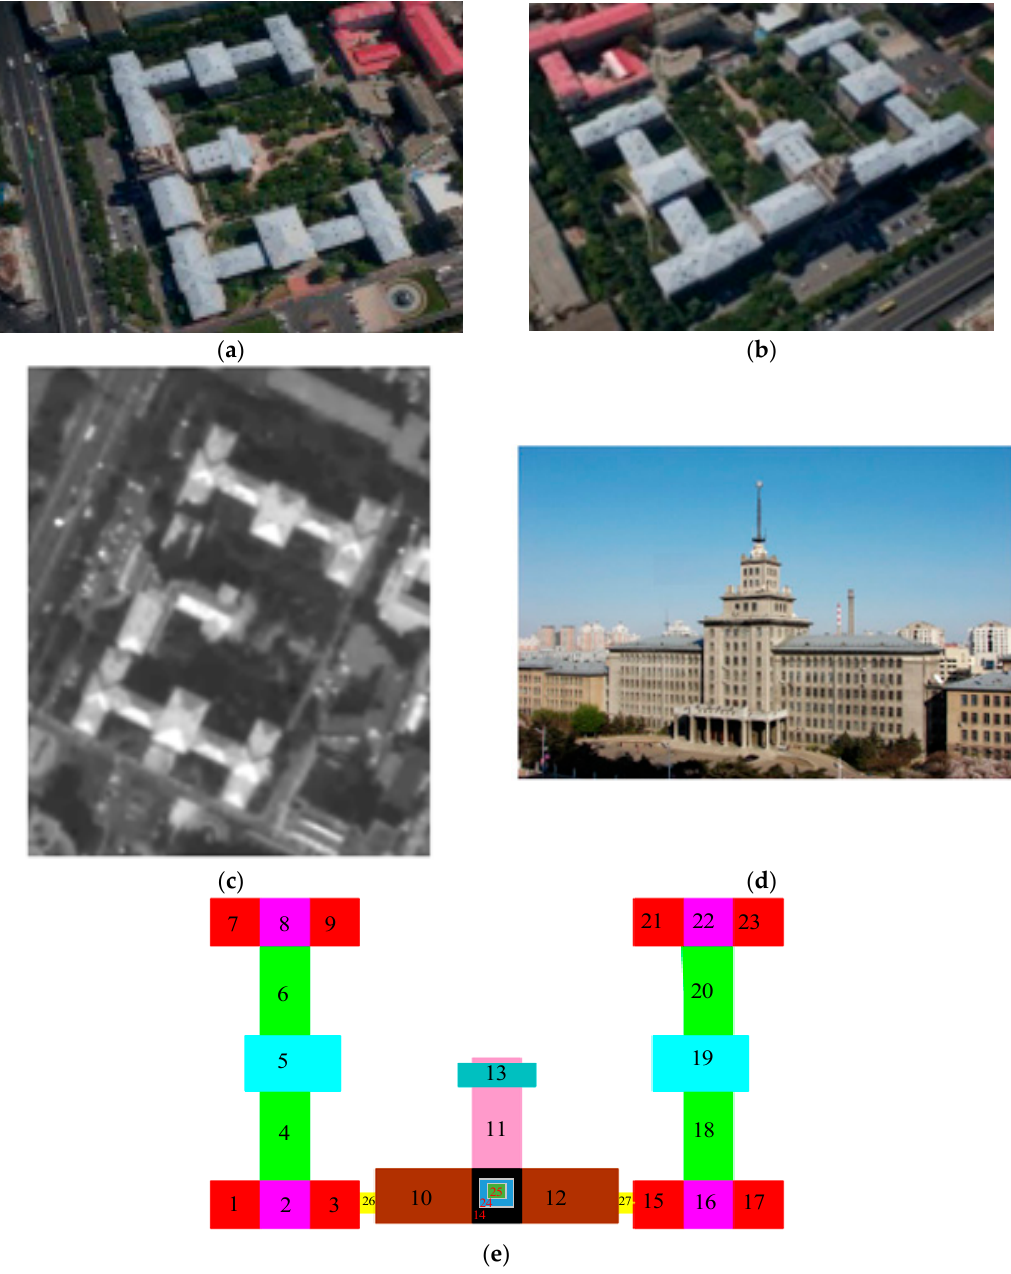
Figure 9. SGSPs of the main building of HIT. ( a , b ) are two airborne images, the resolution is about 0.4 m/pixel; ( c ) is a satellite image, the resolution is 2 m/pixel; ( d ) is the official display of the building. ( e ) is the schematic diagram of the initialized 27 topological